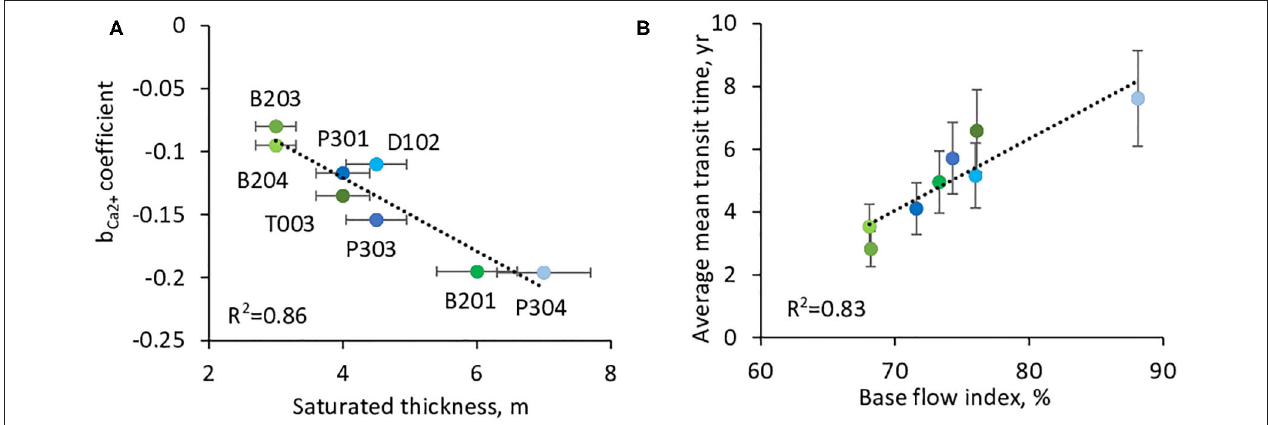
FIGURE 11 | Relations between water storage capacity, b ca2 + coefficient and average mean transit times. (A) Relationship between the b ca2 + coefficient of C-Q relations and the estimated saturated thicknesses. (B) Relationship between the modeled average mean transit times and the base flow index (BFI) of watersheds.